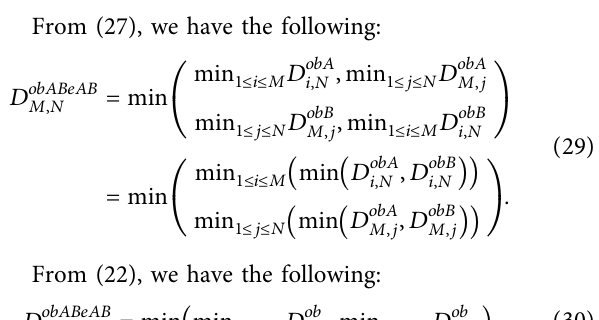
Algorithm 1 is the asymmetric generalized DTW